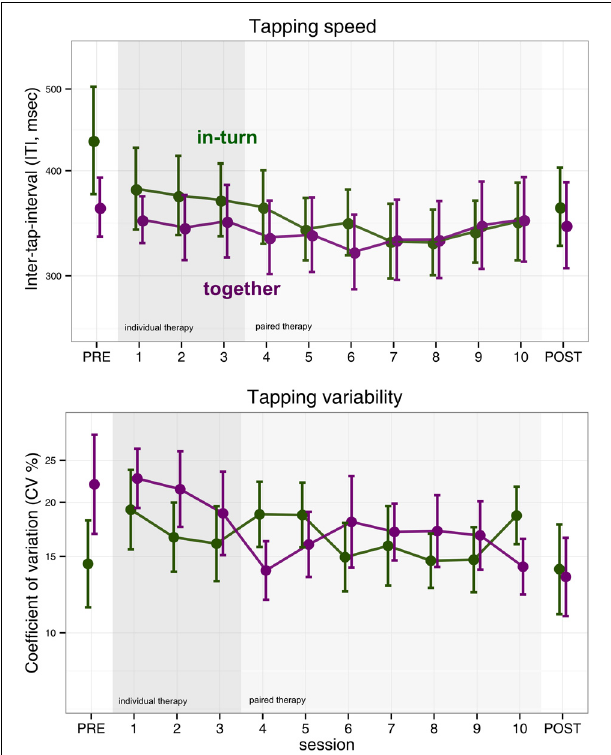
FIGURE 2 | Index finger tapping speed and regularity. Error bars indicate the standard error of the mean.